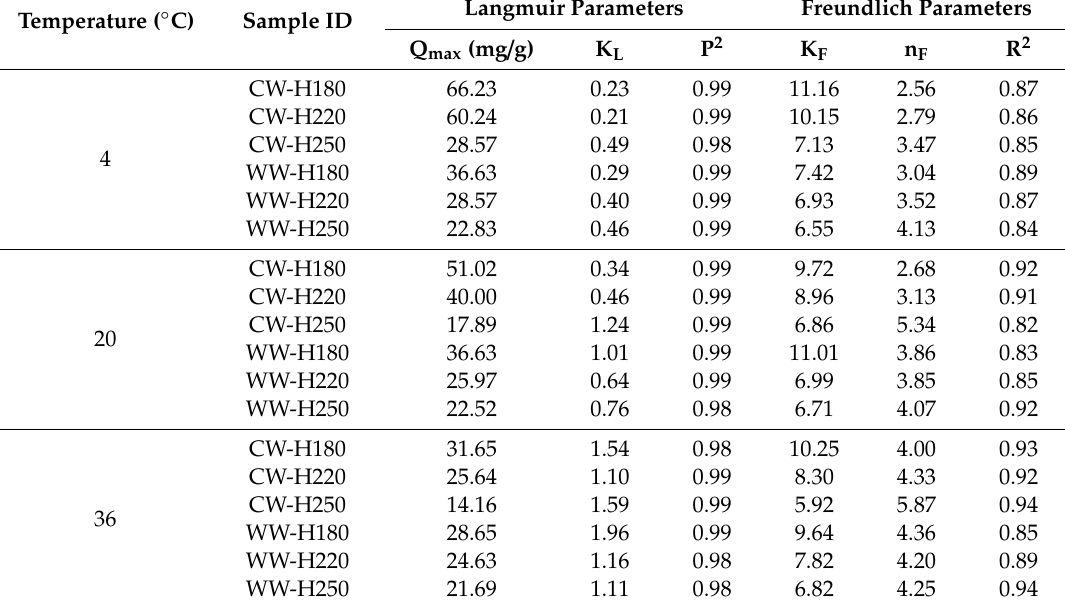
Table 3. Methylene blue adsorption by hydrochars produced from citrus and winery wastes: corresponding isotherm parameters from the Langmuir and Freundlich